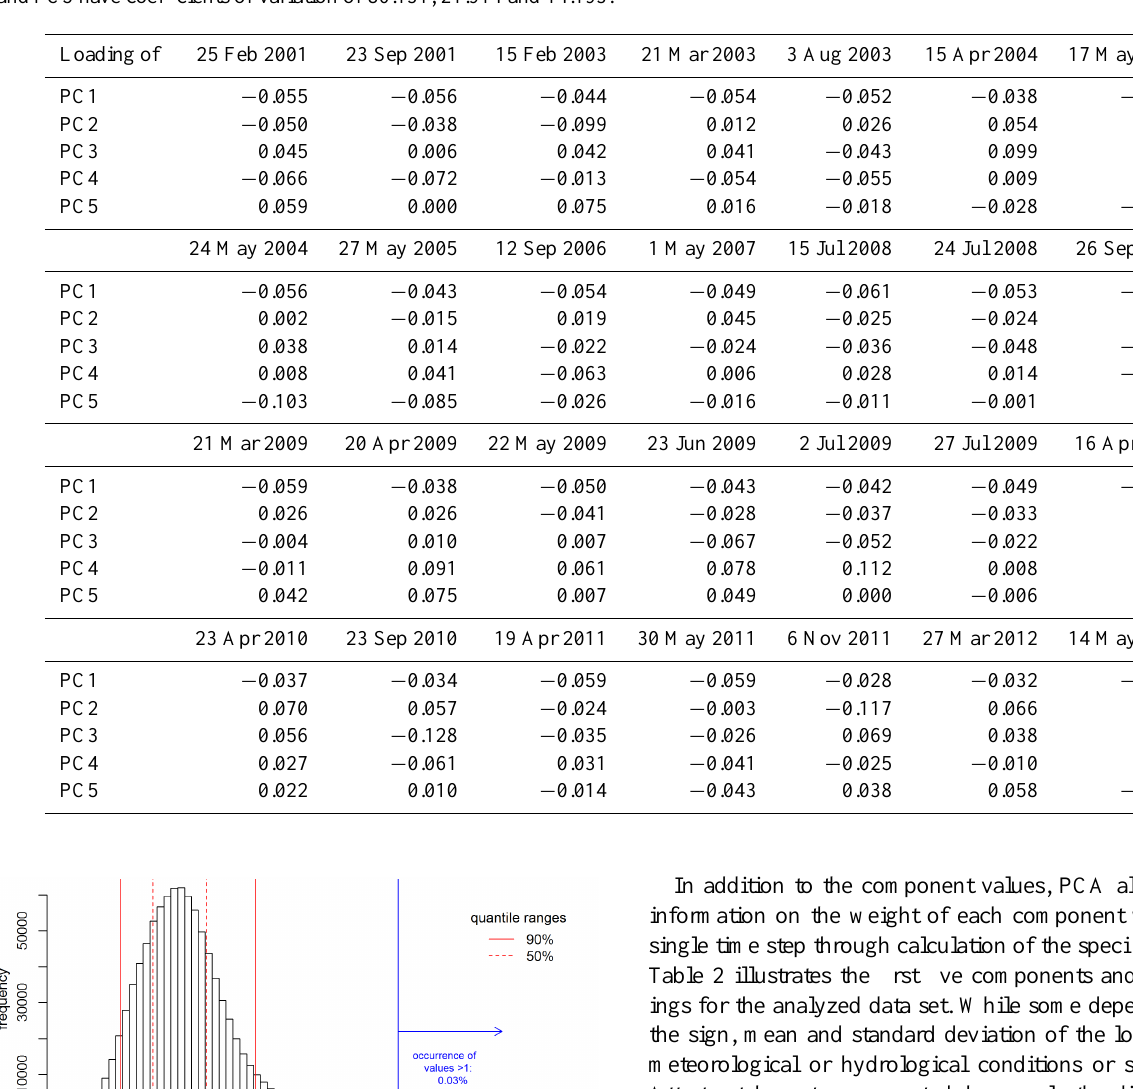
Table 2. Loadings of the first five components (rows) to reproduce the LST time series (columns). The weights differ largely between the time steps. The lowest coefficient of variation for the loadings is calculated for PC1 (0.195); the highest value for PC2 (136.996). PC3, PC4 and PC5 have coefficients of variation of 80.131, 21.914 and 14.193.